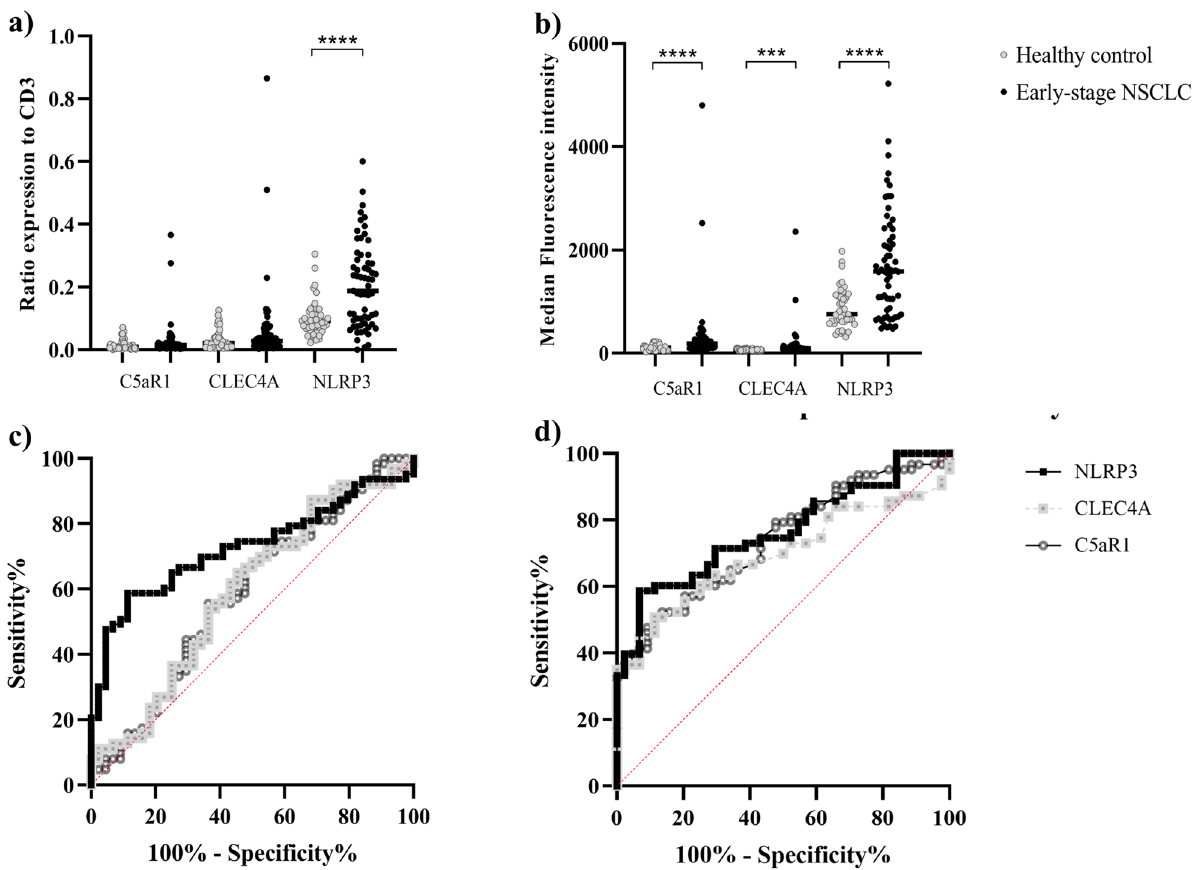
Figure 1. Represented the ratios ( a ), median fluorescence intensity (MFI) ( b ) and adjusted expression ( c ) of C5AR1, CLEC4A and NLRP3 to CD3 + lymphocytes between healthy controls (n = 44) and early-stage NSCLC patients (n = 63). The ROC curve of C5AR1, CLEC4A and NLRP3 ratio and MFI between healthy controls and early-stage NSCLC patient ( c , d ). The CD3 + NLRP3 + MFI provided the most distinguishable between early-stage NSCLC and healthy volunteer at 71.5% sensitivity and 70% specificity.